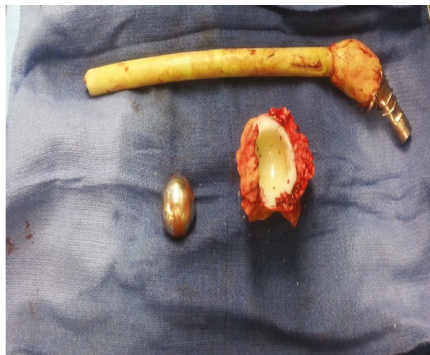
Figure 7: A custom- fi tted temporary prosthesis.